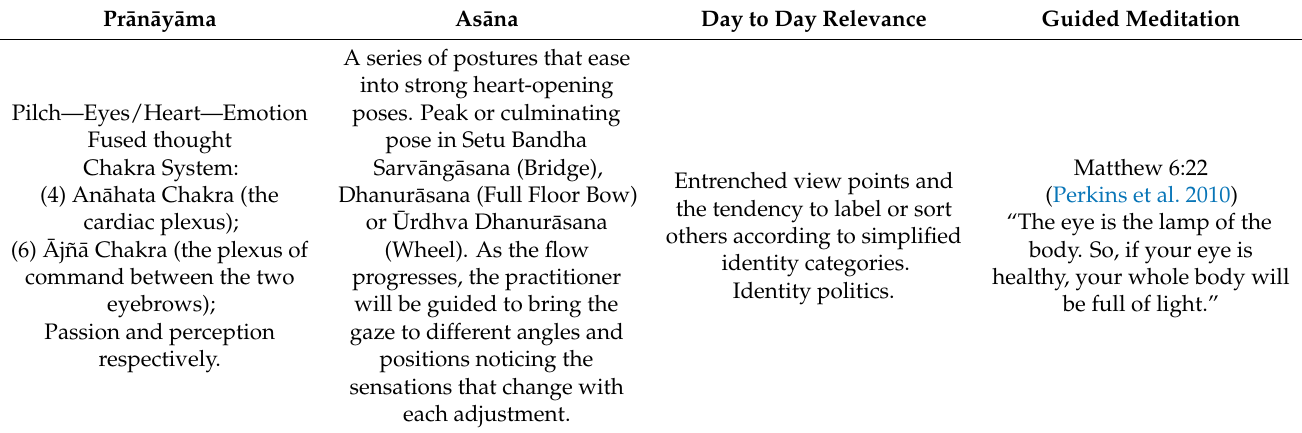
Table 2. The Perceptive Heart—Practice Plan.